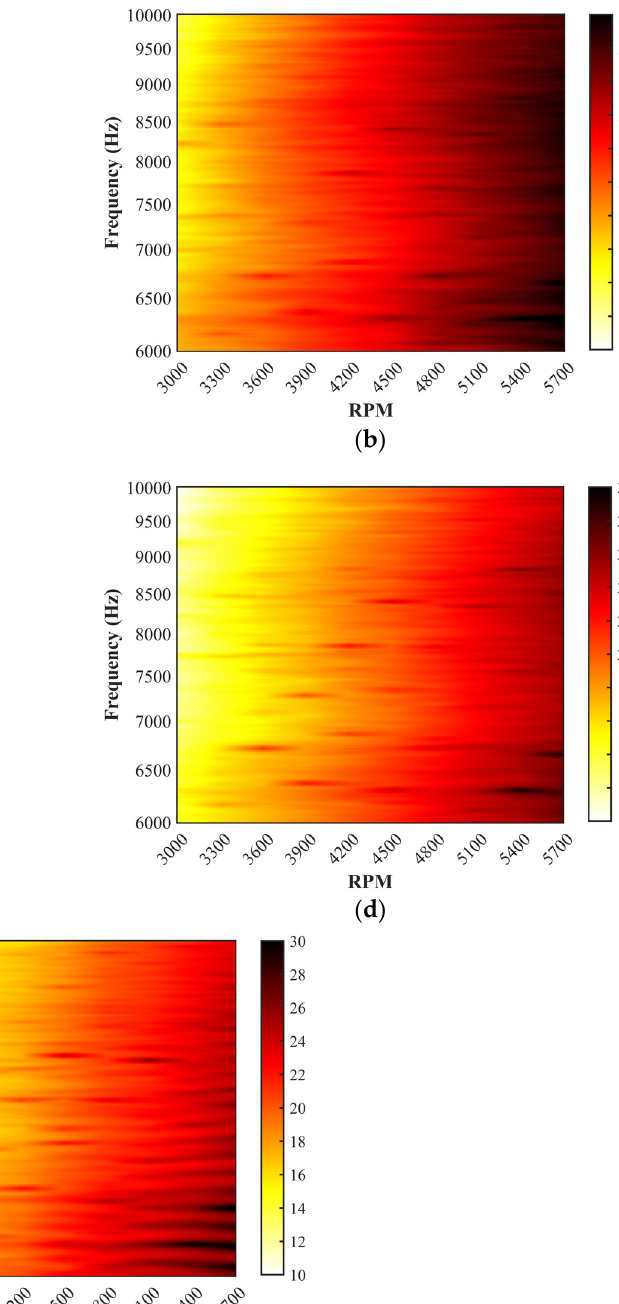
Figure 9. Contour maps of the SPL in dB ( 𝑀𝑖𝑐 2,𝜃 = 25 deg ) over a frequency range of 50–2000 Hz associated with propeller noises: ( a ) two-blade propeller (#1), ( b ) four-blade propeller (#2), ( c ) loop- type propeller (#3), ( d ) wide chord loop-type propeller (#4), and ( e ) DJI Phantom propeller (#5) at various rotational speeds.